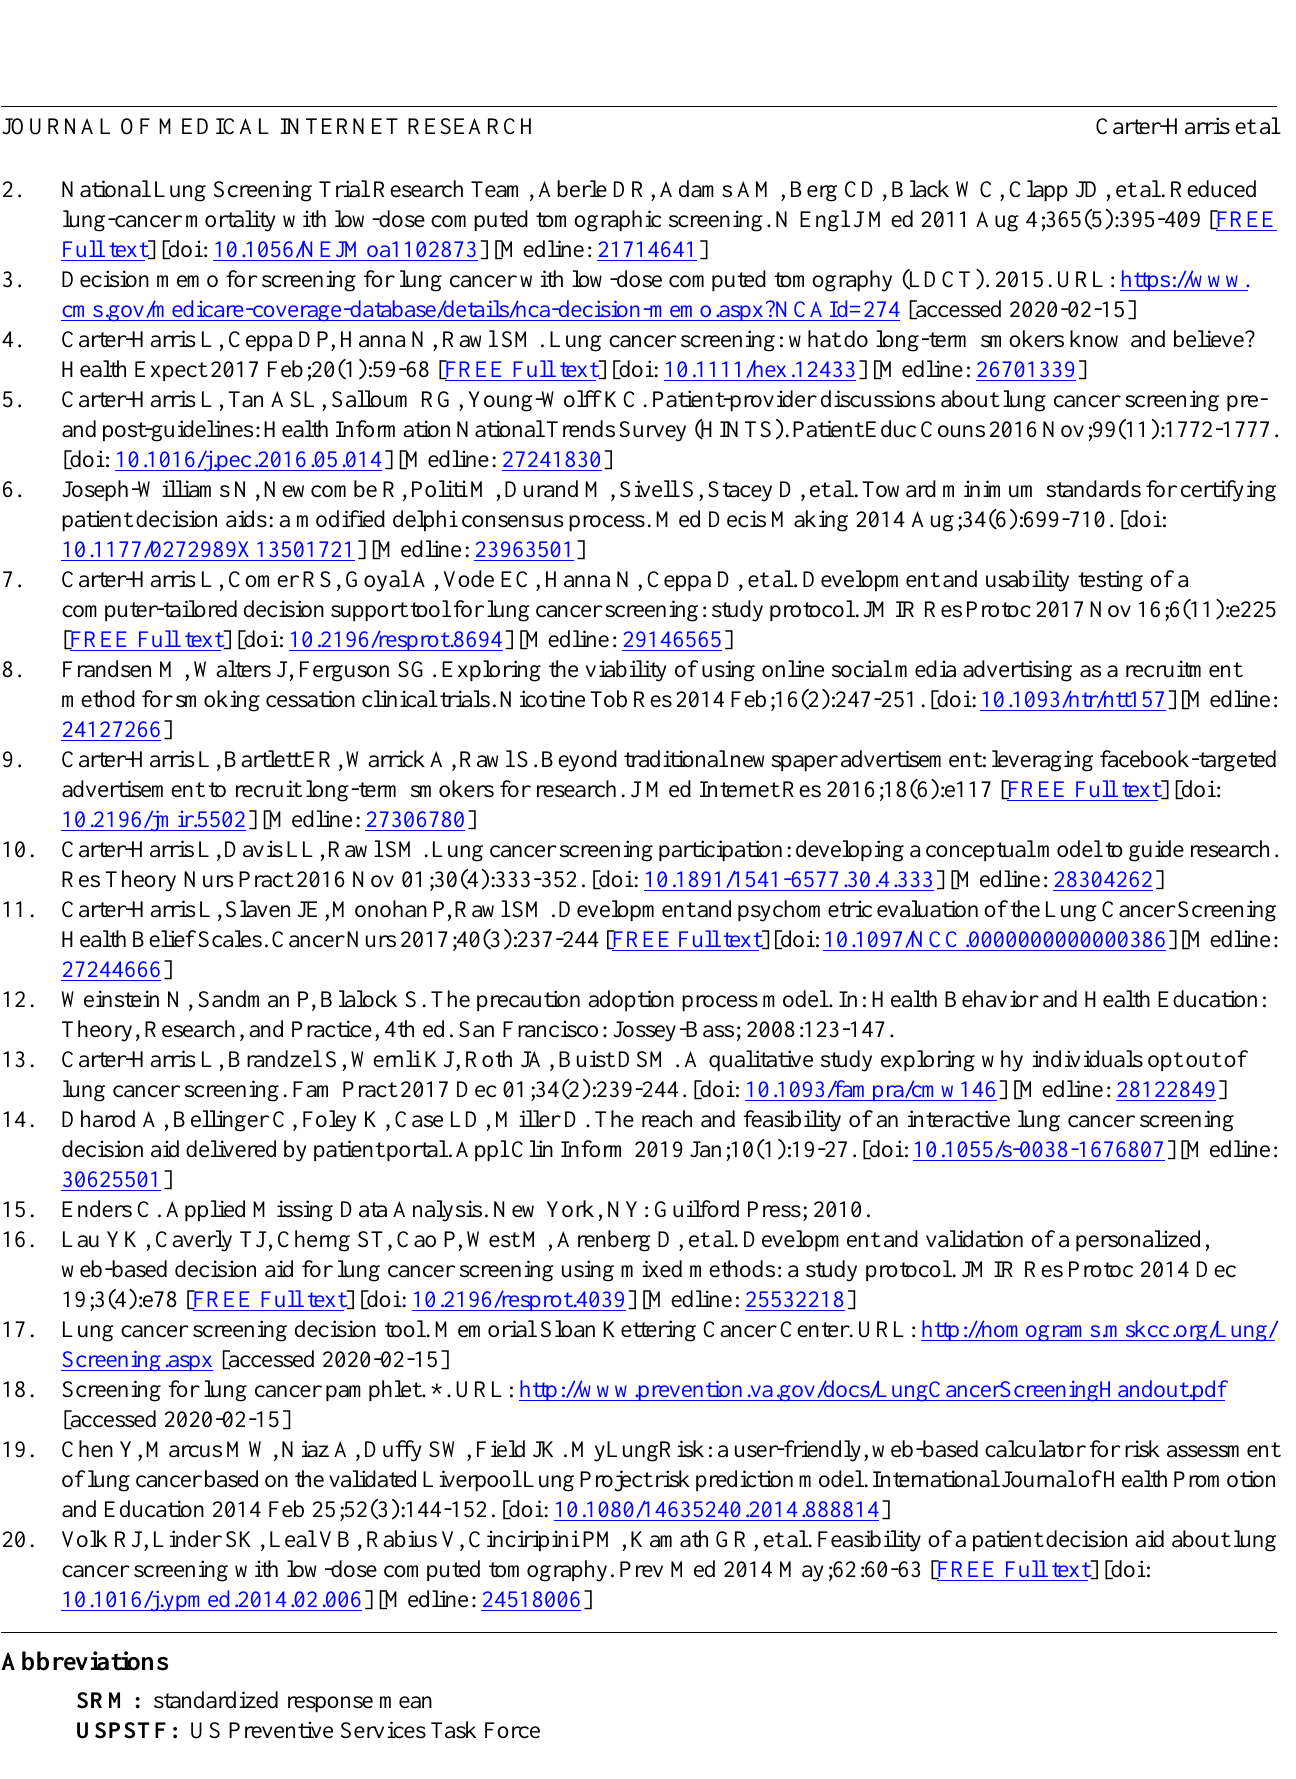
USPSTF: US Preventive Services Task